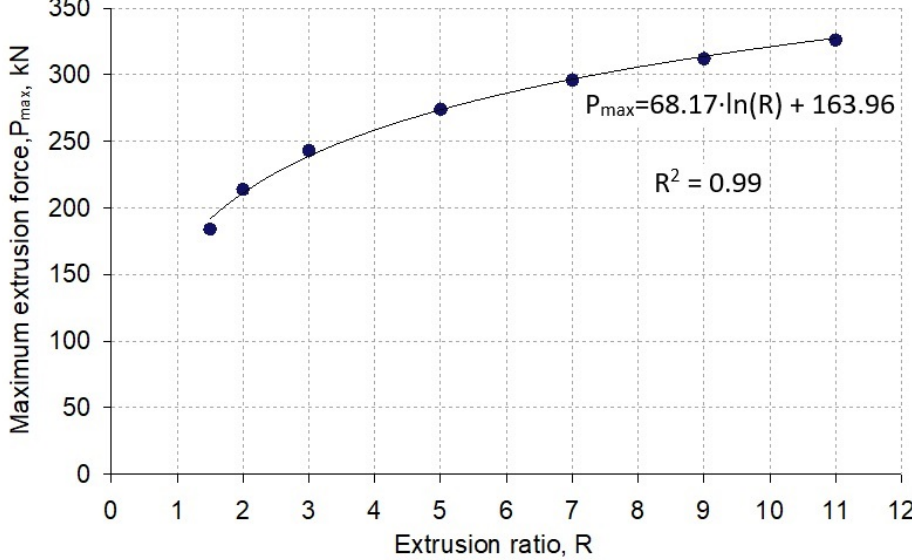
Figure 5. Dependence of the influence of the extrusion ratio R on the maximum extrusion force.